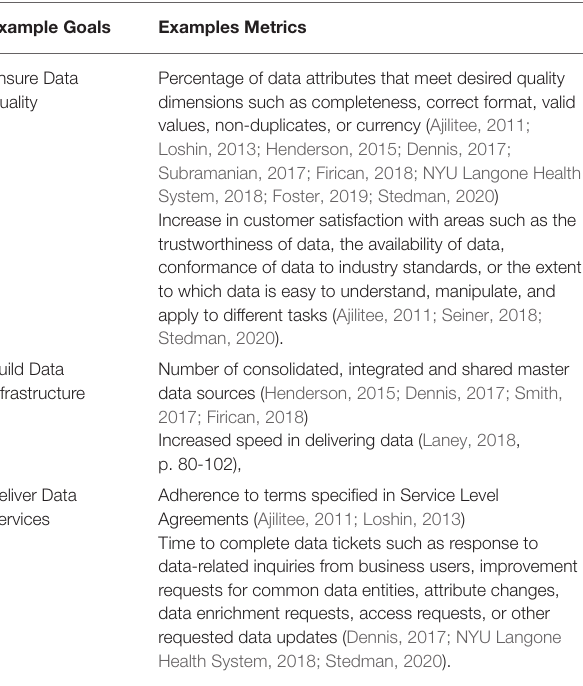
TABLE 3 | Data monetization example goals and metrics. Data Monetization: Value generated when an organization is able to use data to generate financial or competitive value such as increasing revenue, reducing costs, or making better decisions.